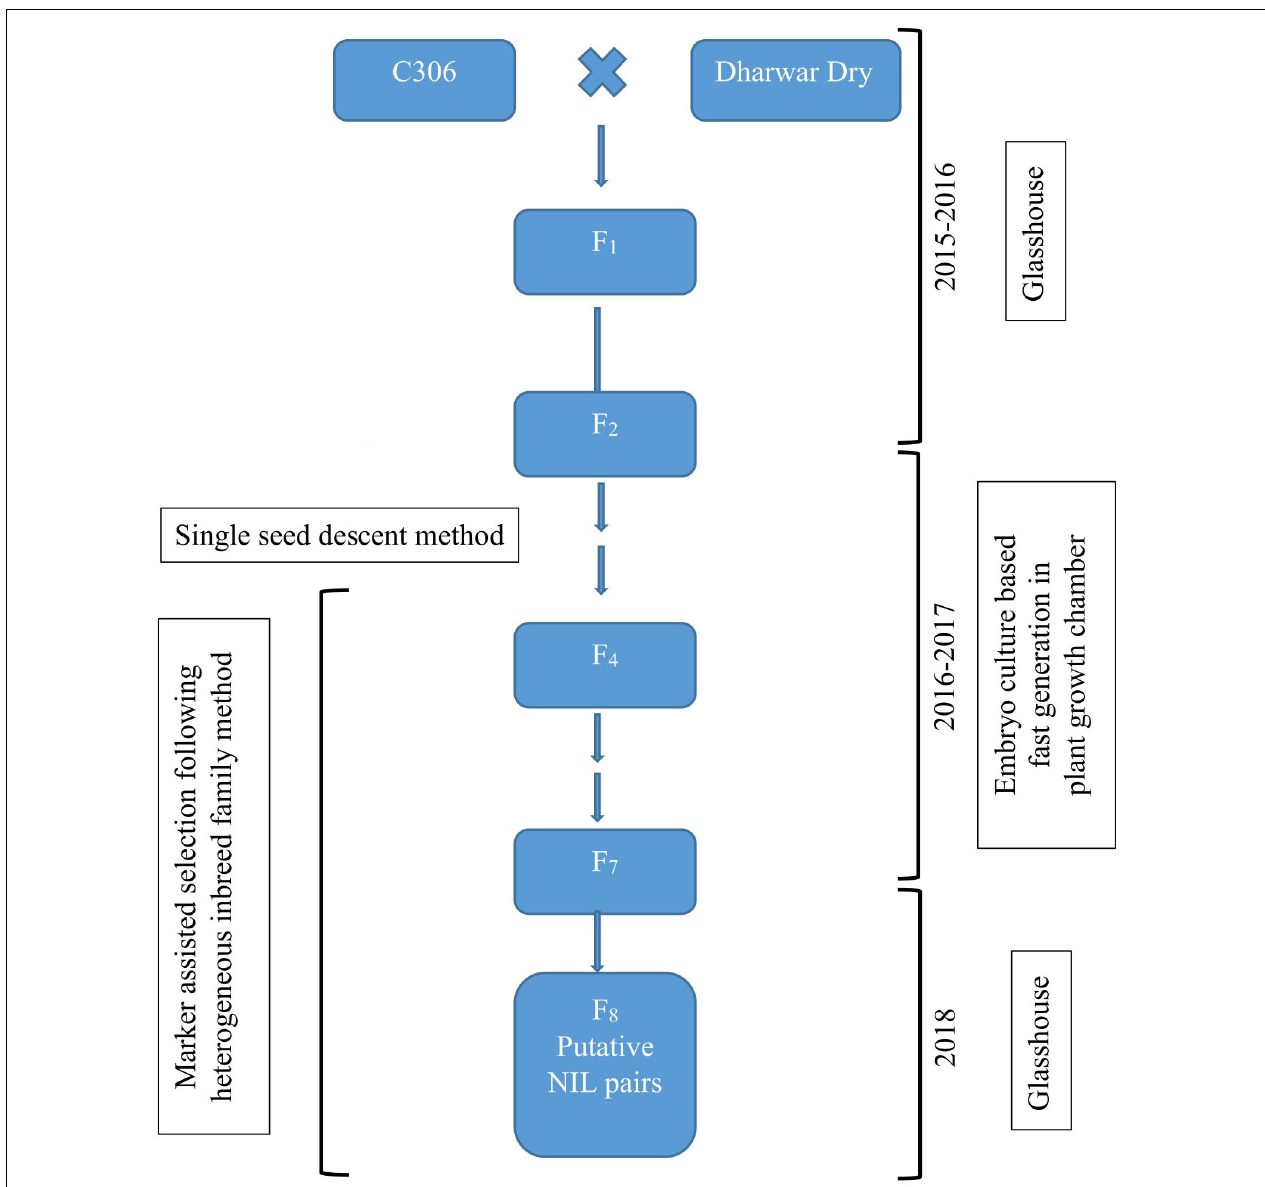
FIGURE 1 | Schematic representation of the development of near-isogenic lines following heterogeneous inbreed family (HIF) method coupled with embryo culture-based fast generation technique.